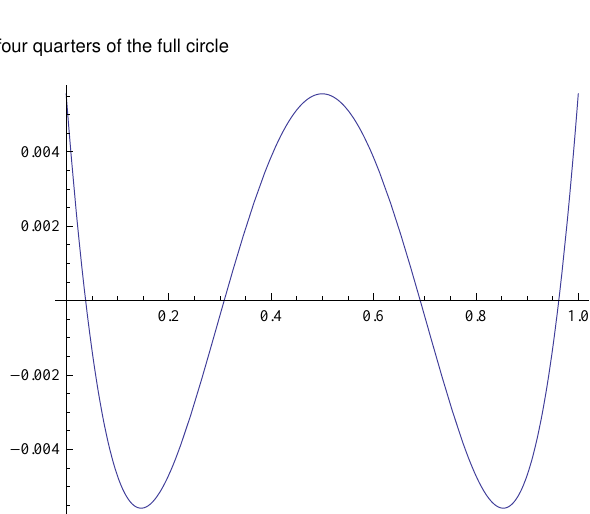
Fig. 6. The error of one out of four quarters of the full